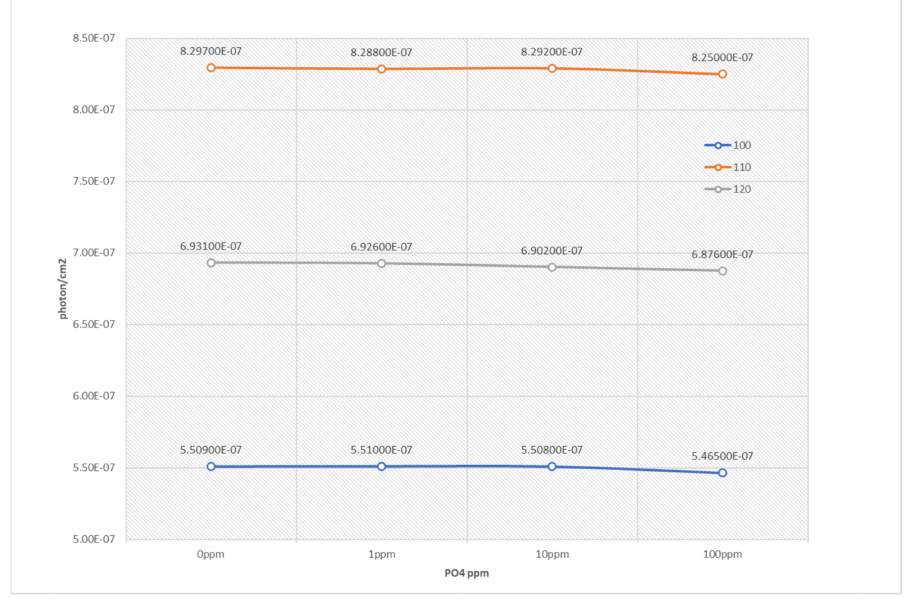
Figure 16. High band photon spectrum B2—air sample vs. contamination.